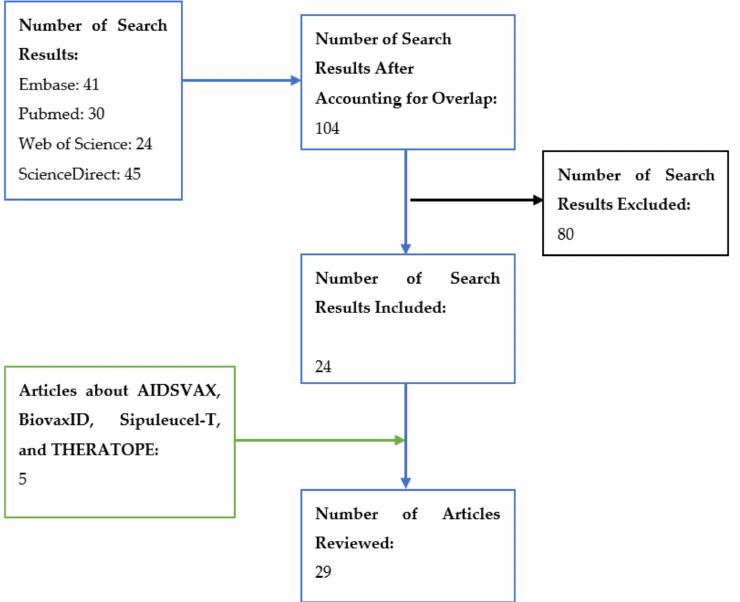
Figure 4. Literature search and article inclusion/exclusion. For Embase, PubMed, and Web of Science, the search terms used were “vaccine”, “fast track”, and “safety”, without any filters. For ScienceDirect, additional search terms “human”, “efficacy”, and “immunization” were used, as well as the “Research Articles”